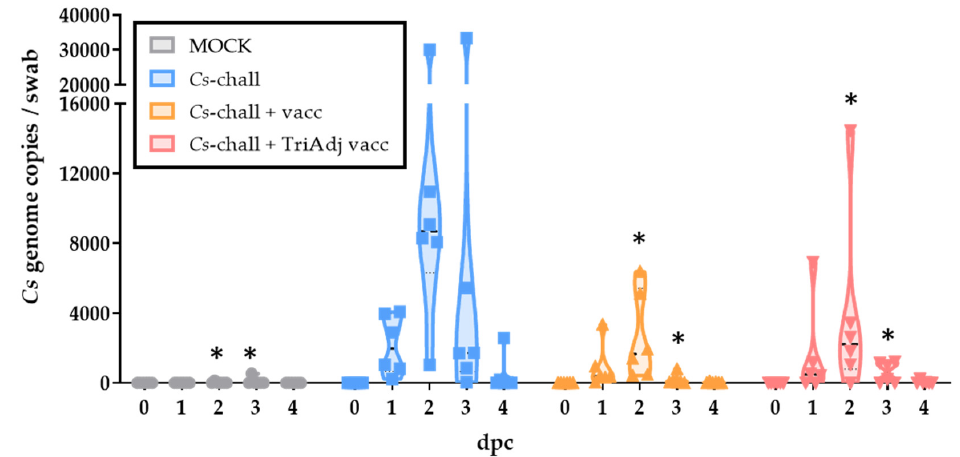
Figure 3. C. suis load is reduced in vaccinated pigs post challenge. C. suis load was analyzed via qPCR in vaginal swabs from MOCK (gray), C. suis challenged ( Cs -chall, blue), C. suis challenged + vaccinated ( Cs -chall + vacc, orange), and C. suis challenged + Tri Adjuvant vaccinated ( Cs -chall + TriAdj vacc, red) pigs prior to challenge (0 days post challenge, dpc) and after challenge (1–4 dpc). Values for individual pigs, medians, and 25 / 75 percentiles are shown. Data were analyzed using a repeated-measures two-way ANOVA in comparison to Cs -chall animals and corrected for multiple comparisons with Dunnett’s multiple comparisons test. * p < 0.05.